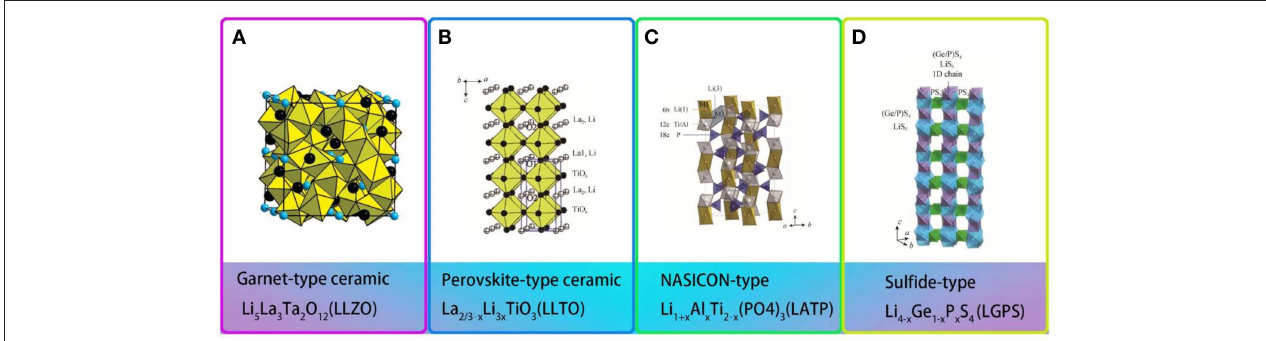
FIGURE 5 | Structures of different types of fast ion conductors (A) Framework of garnet-type ceramic [Reproduction with permission from O’Callaghan et al. (2008) Copyright © 2008, American Chemical Society] (B) Crystal structure of perovskite-type ceramic. [Reproduction with permission from Stramare et al. (2003) Copyright © 2003, American Chemical Society] (C) Crystal structure of NASICON-type ceramic. [Reproduction with permission from Perez-Estebanez et al. (2014) Copyright © 2015, The Royal Society of Chemistry] (D) Crystal structure of Sulfide-type ceramic. [Reproduction with permission from Kamaya et al. (2011) Copyright © 2011, nature]. TABLE 3 | Summary of fast-ion conductive ceramics/polymer solid electrolytes. Year Polymer electrolyte ingredients Ionic conductivity